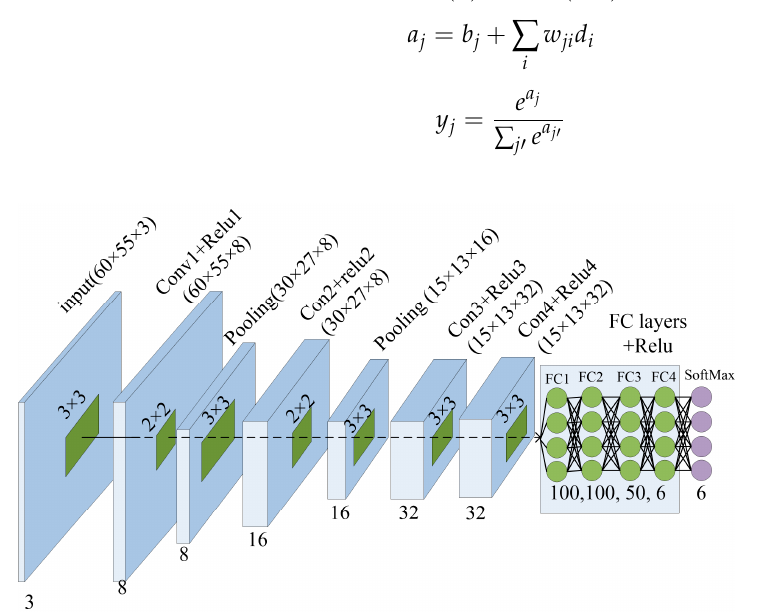
Figure 2. Proposed DL architecture for HSE.